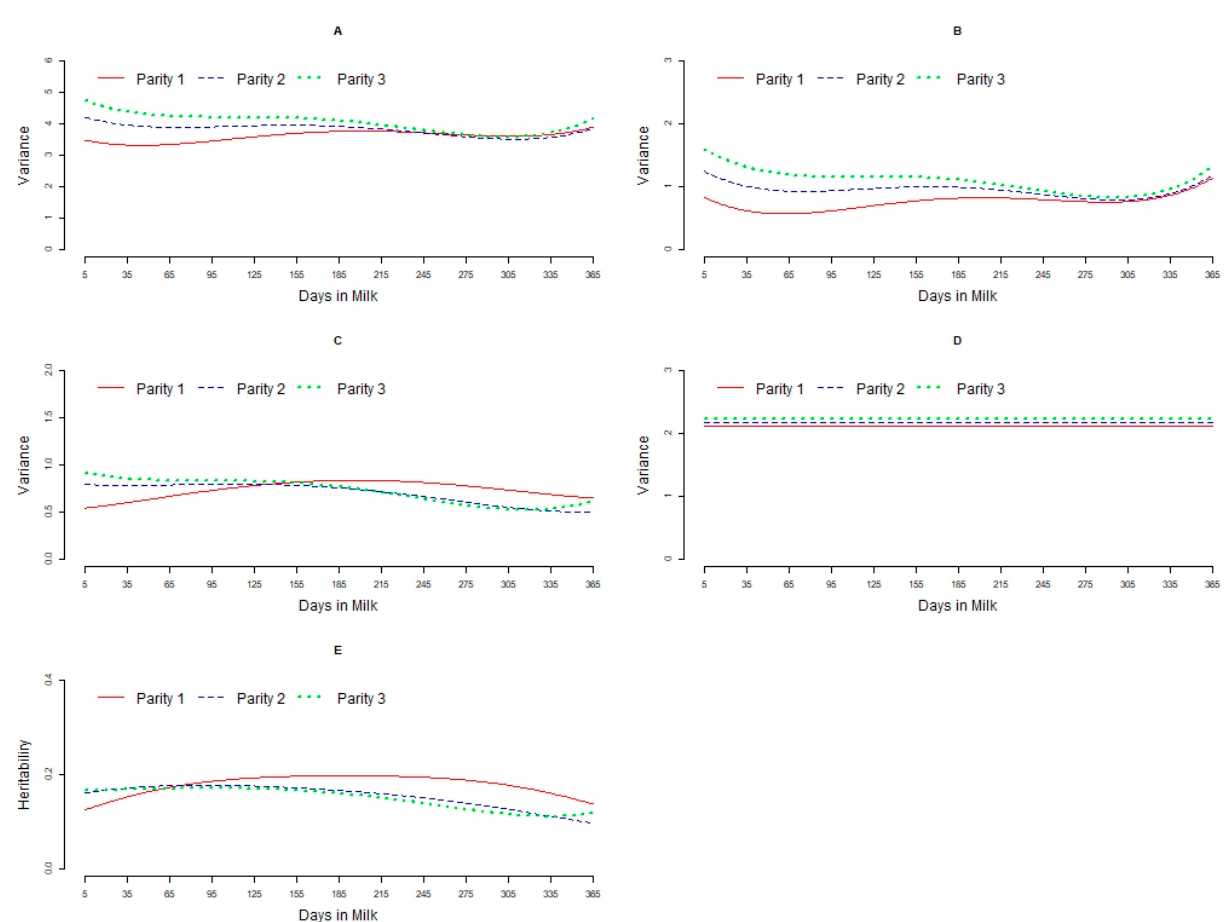
Figure 2. Phenotypic ( A ), permanent environmental ( B ), additive genetic ( C ), residual variance ( D ), and heritability ( E ) estimated for SCS over days in milk in the first three parities.